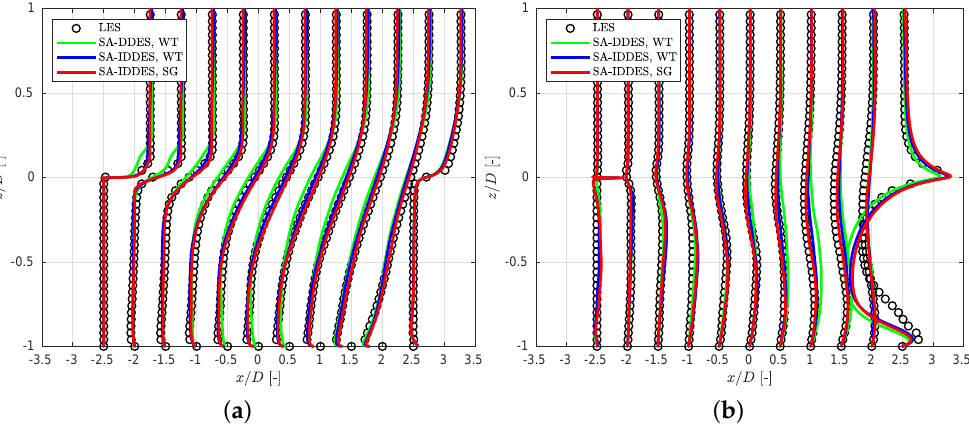
Figure 9. Time-averaged velocity profiles. WT and SG denote the wind tunnel model and the simplified geometry, respectively. ( a ) Streamwise velocity < u > . ( b ) Vertical velocity < w >